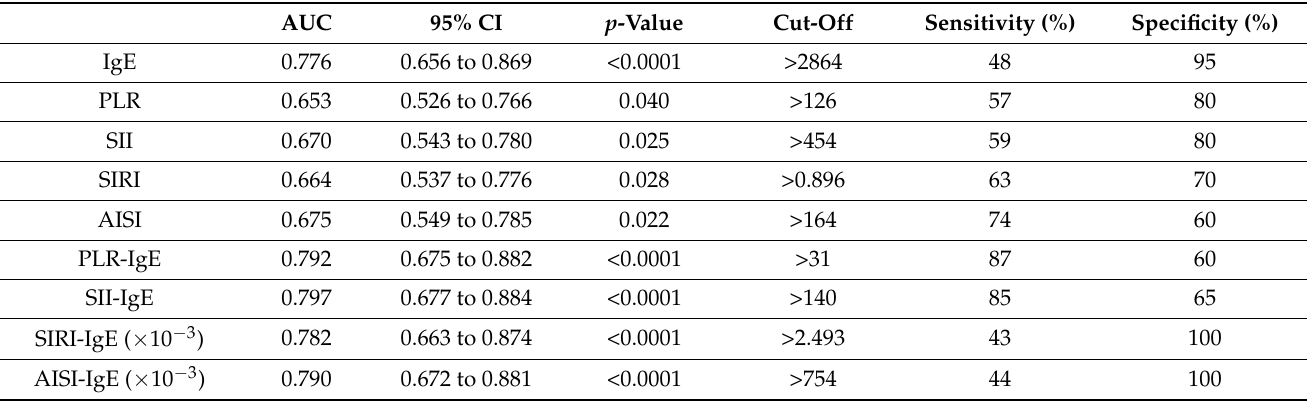
Table 4. Receiver operating characteristics (ROC) curves and prognostic accuracy of individual and combined haematological parameters.